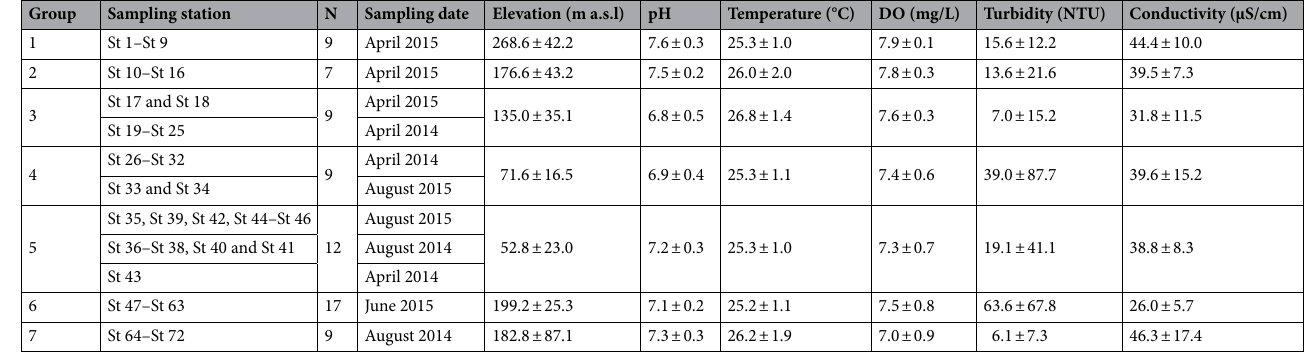
Table 1. Details of sampling regime and environmental parameters in the Baleh River